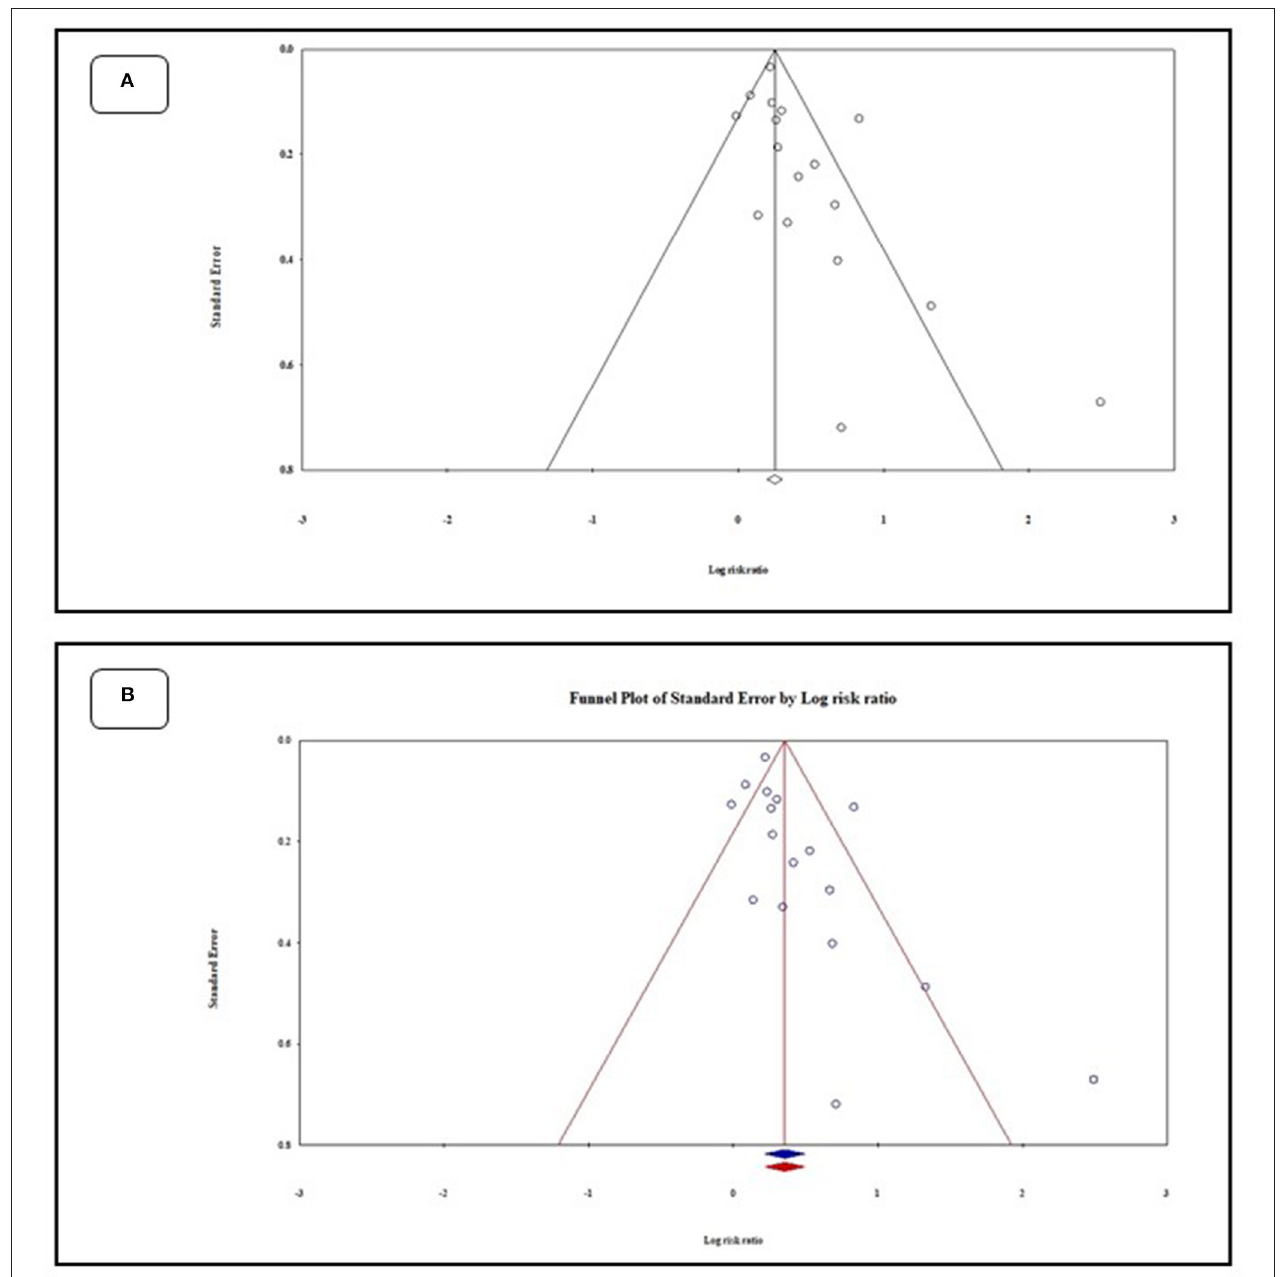
FIGURE 5 | Funnel plots of meta-analysis before (A) and after (B) applying the fill and trim